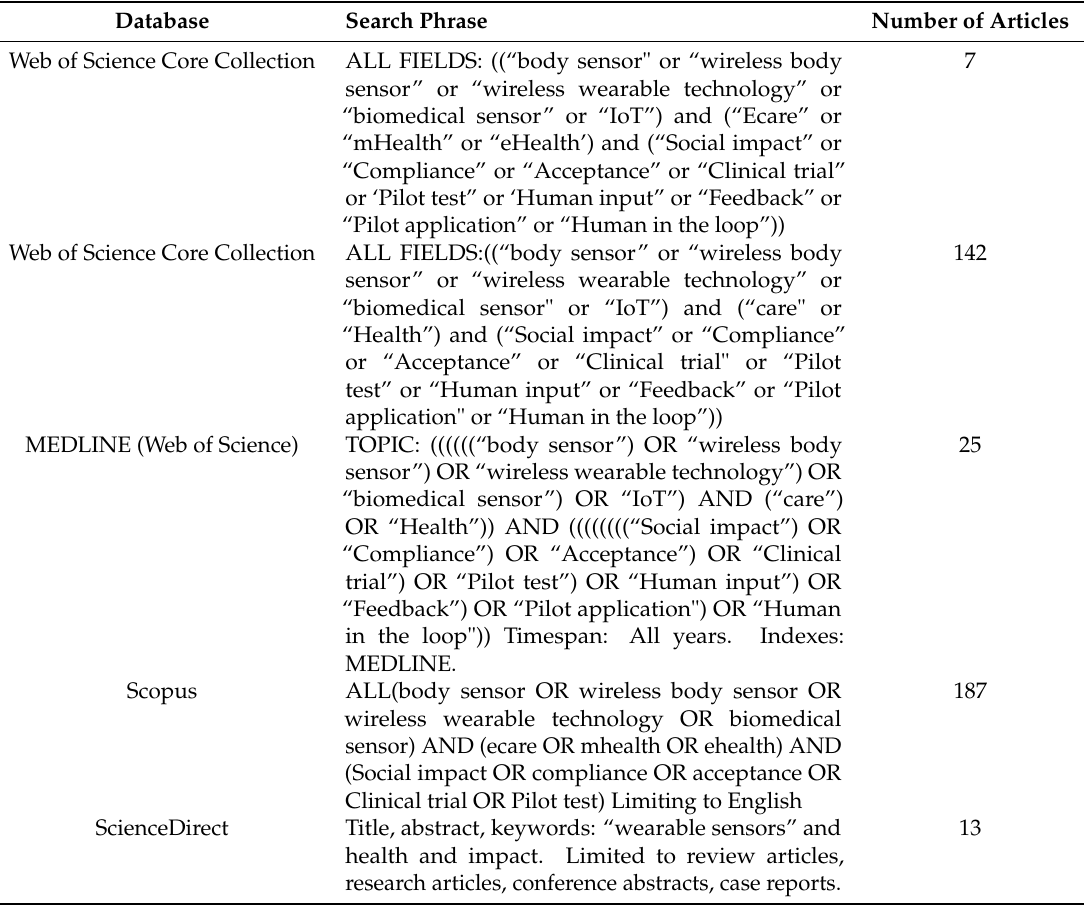
Table 1. An overview of search phrases and databases used during article